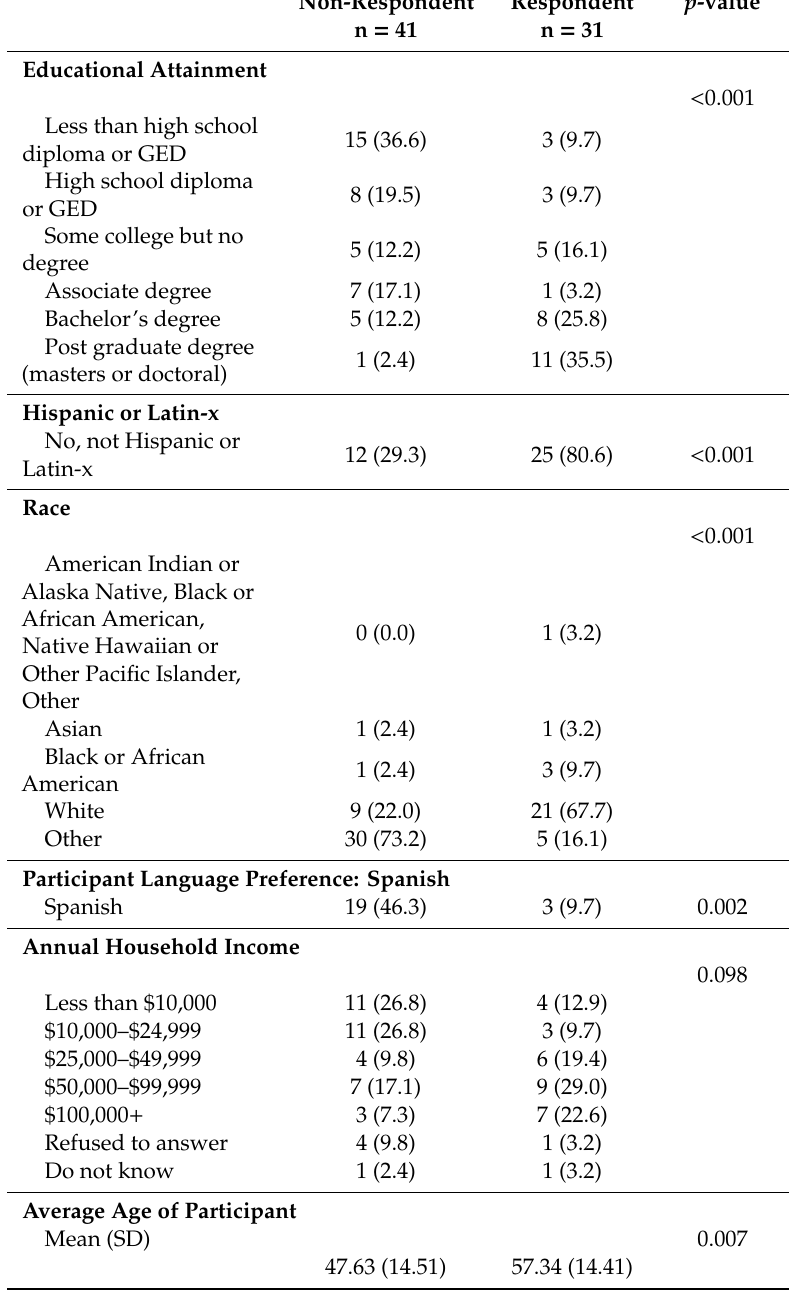
Table 1. Demographics of the respondents and non-respondents to the report-back